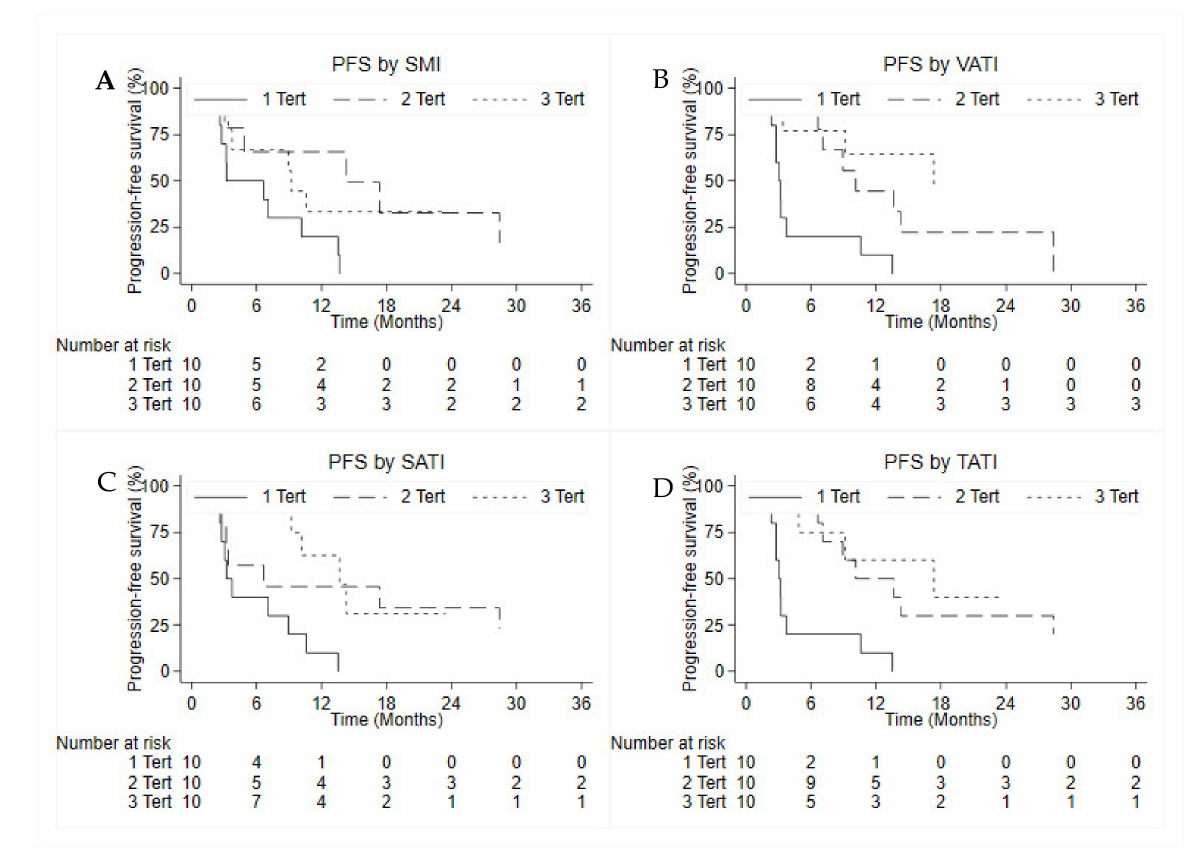
Figure 5. Correlation between PFS and SMI ( A ), VATI ( B ), SATI ( C ) and TATI ( D ).